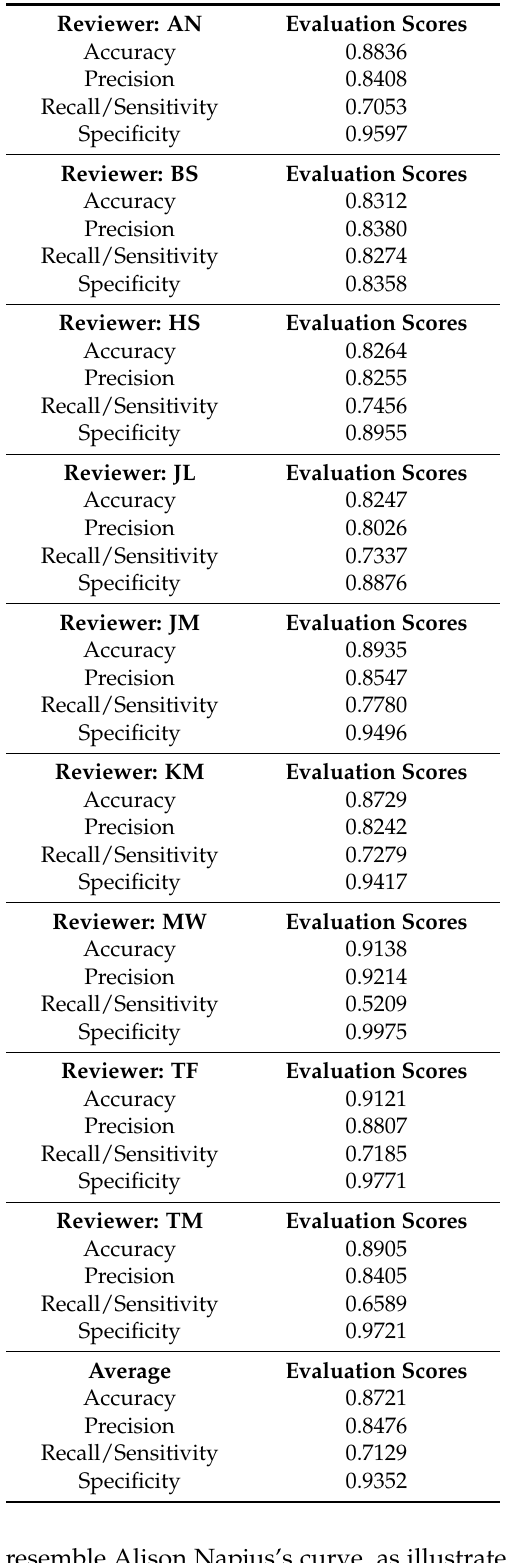
Table 7. Evaluation results for each wine reviewer based on